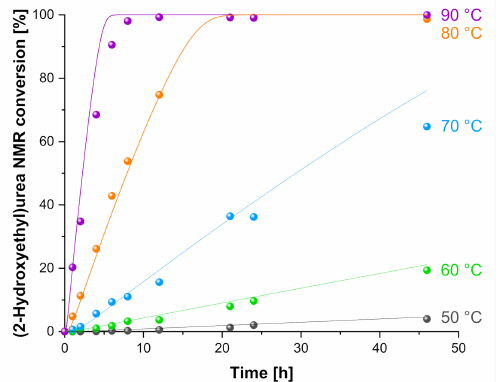
Figure 4. Time-dependent formation of (2-hydroxyethyl)urea as a function of reaction temperature. The reactions were conducted with 5% v/v of ethanolamine in H 2 O/D 2 O with a 6-fold excess of urea (ethanolamine/urea = 1:6). The fitted lines correspond to the results of the kinetic modelling (see Section 3.5).